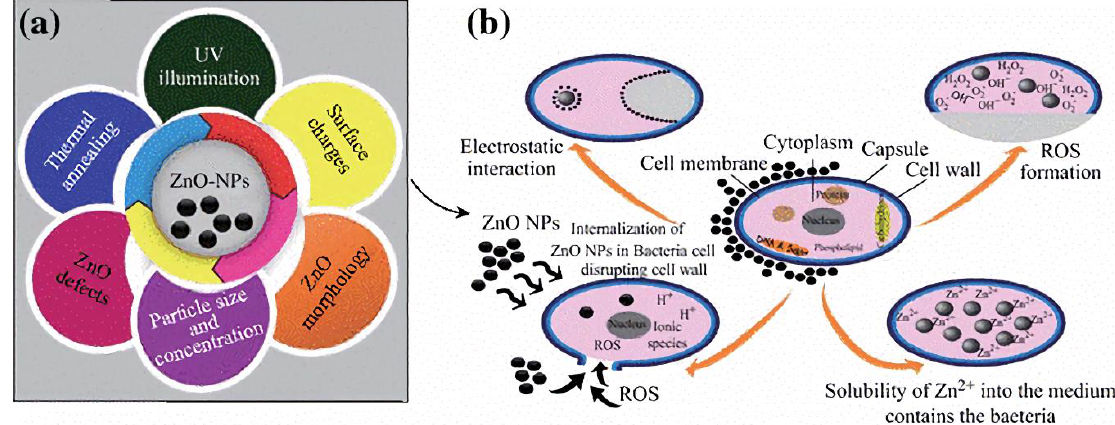
Figure 2. ( a ) Essential parameters of ZnO NPs associated with its antibacterial activity. ( b ) The possible antibacterial mechanisms of ZnO NPs. Reproduced with permission from ref [47].